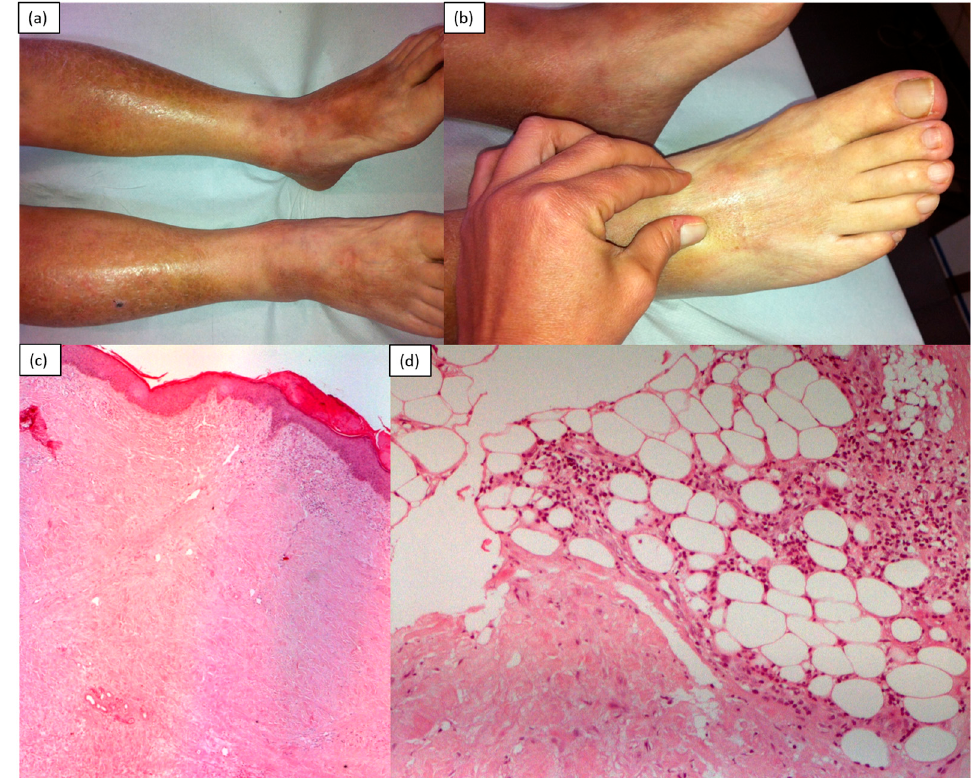
Figure 7. A 75-year-old male patient, suffering from hypereosinophilic syndrome, diabetes mellitus, benign prostatic hypertrophy, hyperuricemia and gout, for some months had developed asthenia, muscle weakness accompanied by massive edema of the legs and forearms and serotonin-induced low-grade fever. In the meantime, the progressive hardening of the skin and subcutis was observed on the limbs ( a ), with a marked limitation in skin pliability ( b ). H&E specimen of skin (original